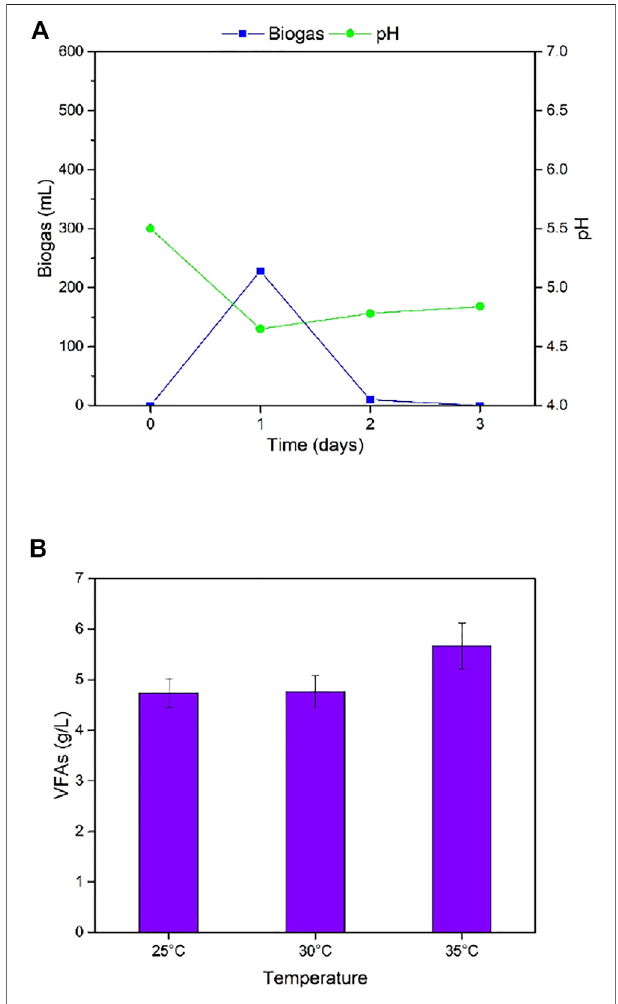
FIGURE 4 | (A) Daily biogas production and pH for the fi rst stage of TS- AD at 35 ° C (B) Total VFA accumulations for the fi rst stage of TS-AD operated at different temperatures (VFA = Volatile fatty acids, TS-AD = Two stage anaerobic